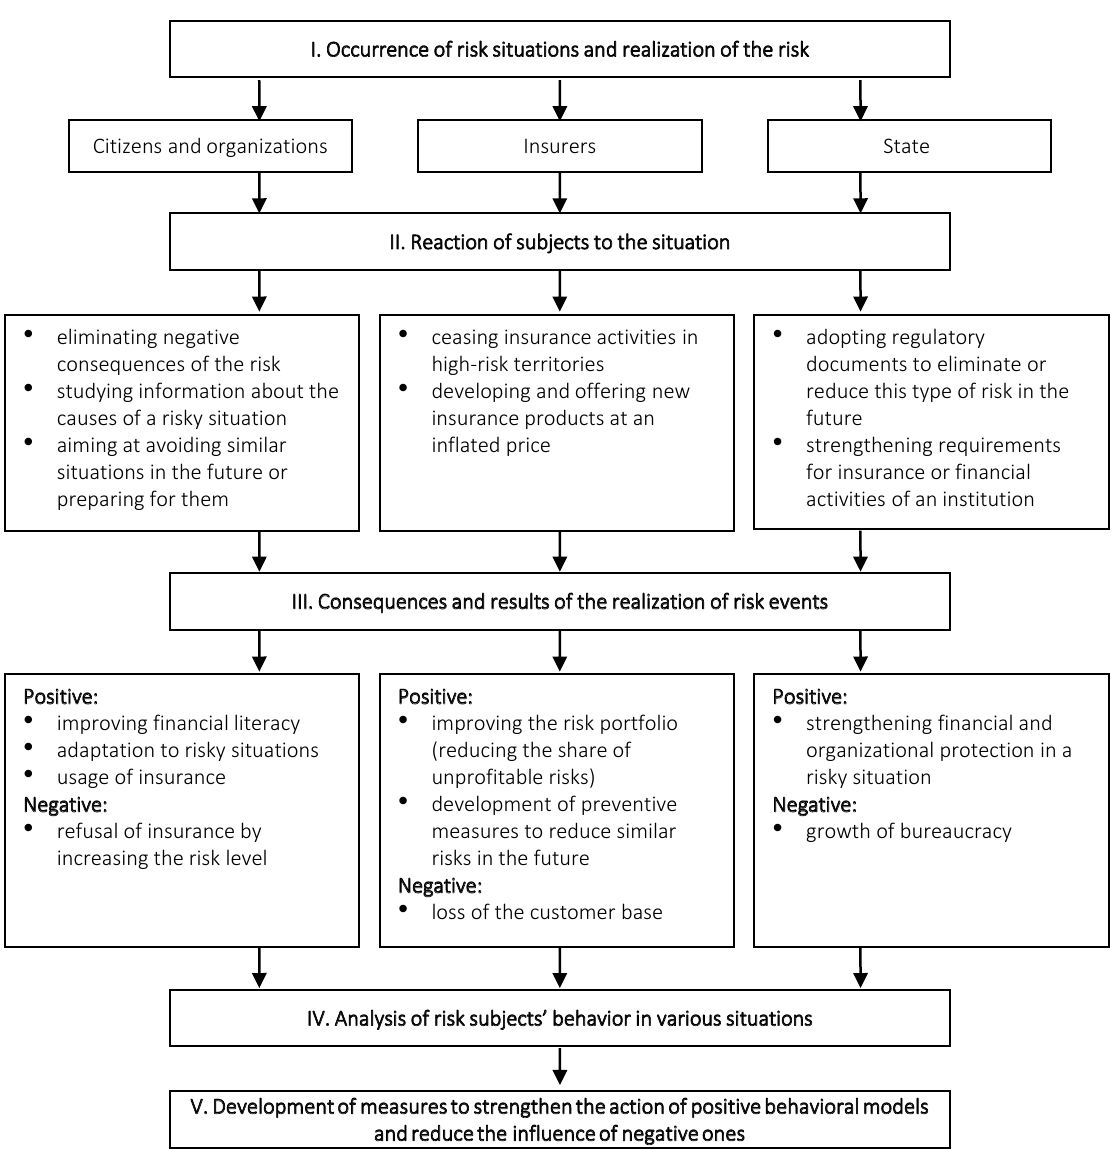
Figure 2. The model of economic entities’ behavior in a risky